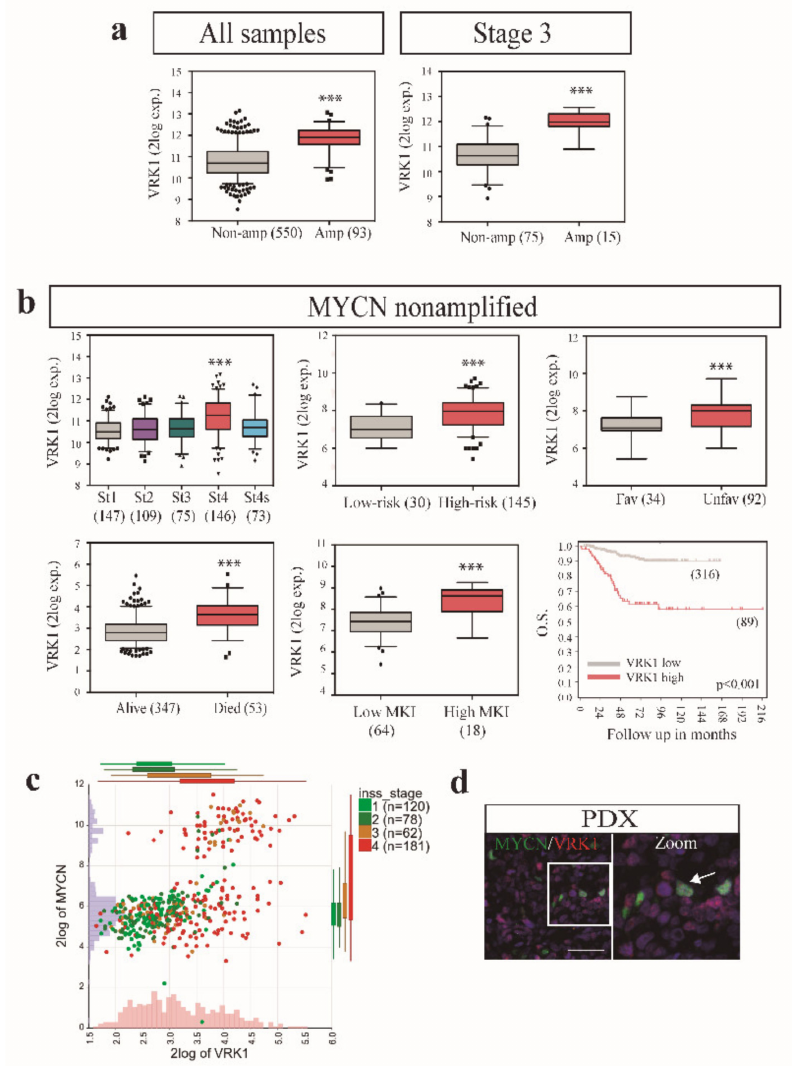
Figure 5. VRK1 associates with neuroblastoma progression independently of MYCN amplification. ( a ) Expression of VRK1 in MYCN-amplified or MYCN nonamplified NB tumors (GSE45547); ( b ) VRK1 expression on patient tumor samples without MYCN amplification separated by INSS stage (GSE45547), risk, histology, outcome (GSE62564) or mitotic-karyorrhexis index (MKI) (GSE3446). Kaplan curves show overall survival probability from patients stratified according to VRK1 expression (GSE45547). Number of samples shown in brackets. ***: p < 0.001; ( c ) two gene (VRK1 and MYCN) expression analyses in tumor samples (dataset GSE49710). Number of samples in each INSS stage are shown and separated by colors; ( d ) immunofluorescence showing MYCN and VRK1 staining in a representative PDX